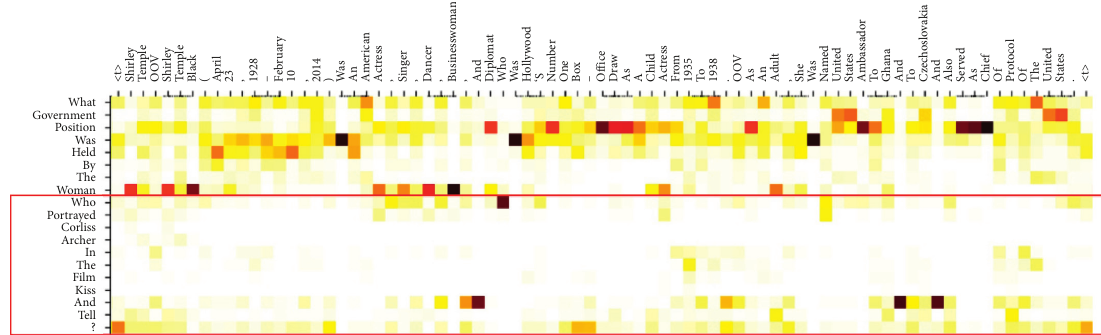
Figure 4: Attention heat map of the baseline